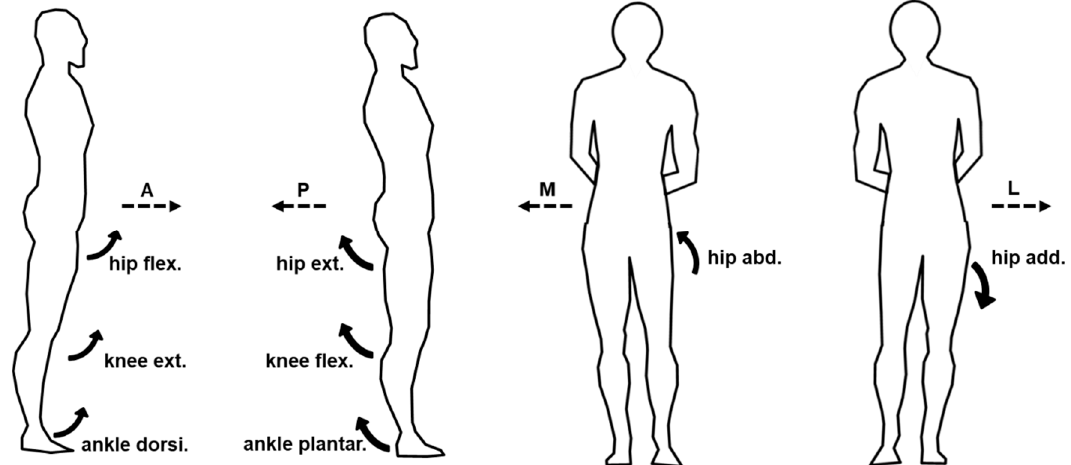
Figure 11. Rapid lower-limb joint moment responses evoked by the unexpected waist-pull perturbations. (Note that the right leg was the dominant leg. A : anterior pulls; P : posterior pulls; M : medial pulls; L : lateral pulls).